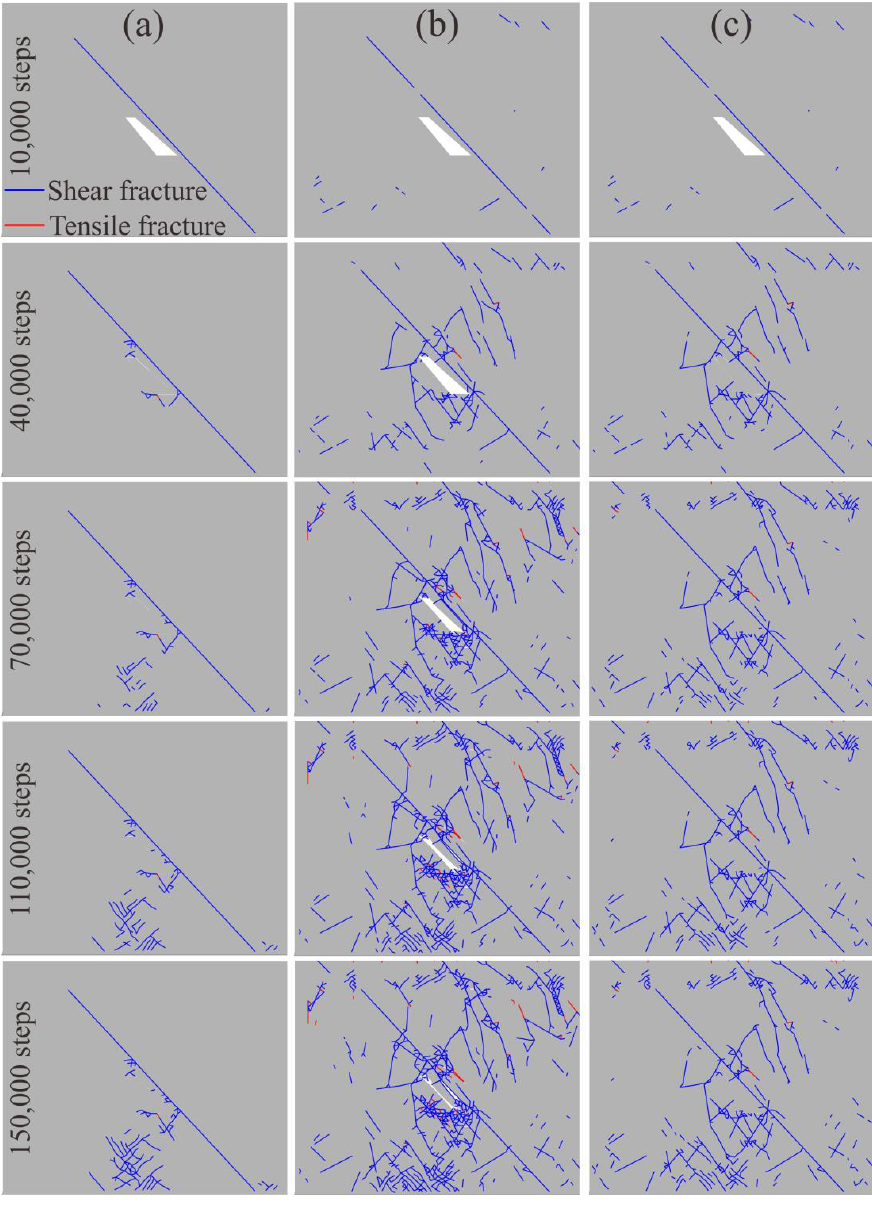
Figure 6. Fracture generation process of surrounding rock caused by excavation. ( a ) Condition of backfill mining without fissures; ( b ) condition of mining with fissures; and ( c ) condition of backfill mining with fissures.